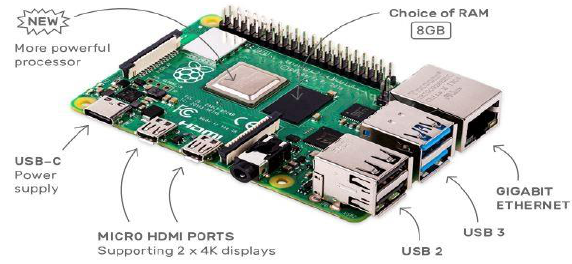
Figure 9. Raspberry Pi 4 8GB of RAM .